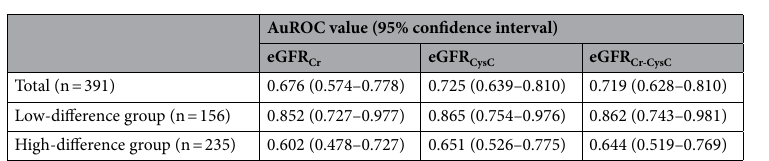
Table 3. Comparison of AuROC values of eGFR equations for hyperphosphatemia in the CKD grade 3 subpopulation. AuROC Area under the receiver operating characteristic curve, CKD Chronic kidney disease, eGFR Estimated glomerular filtration rate, eGFR Cr eGFR based on creatinine, eGFR CysC eGFR based on cystatin C, eGFR Cr-CysC eGFR based on both creatinine and cystatin